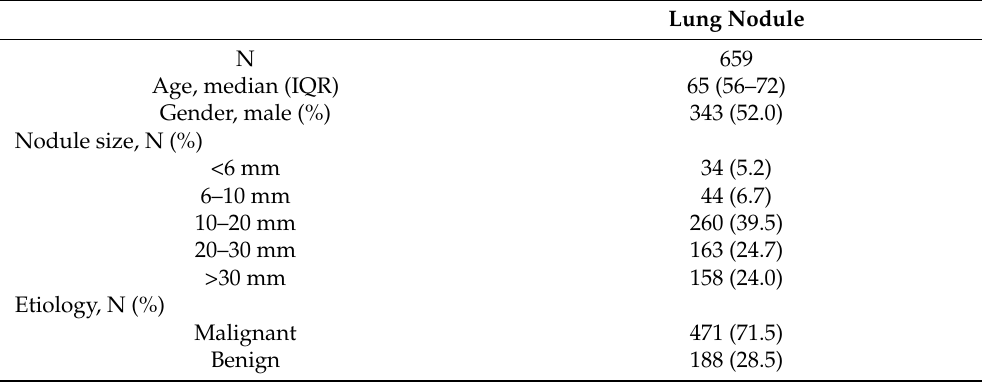
Table 2. Characteristics of the VGHTPE training dataset and testing